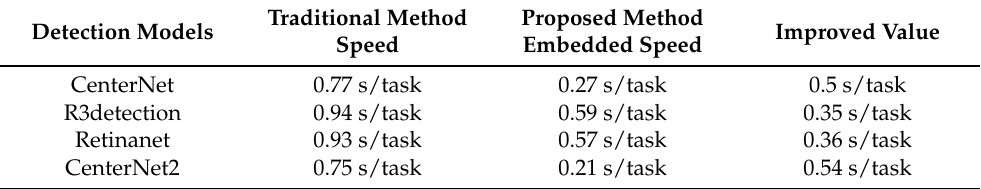
Table 7. Inference Time